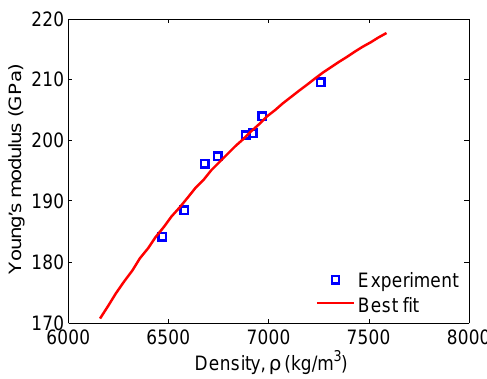
Figure 6. The variation of Young’s modulus, retrieved from data generated by the setup employing the thin piezoelectric disc transducers, versus the ternary Fe-Ti-Al alloy density.